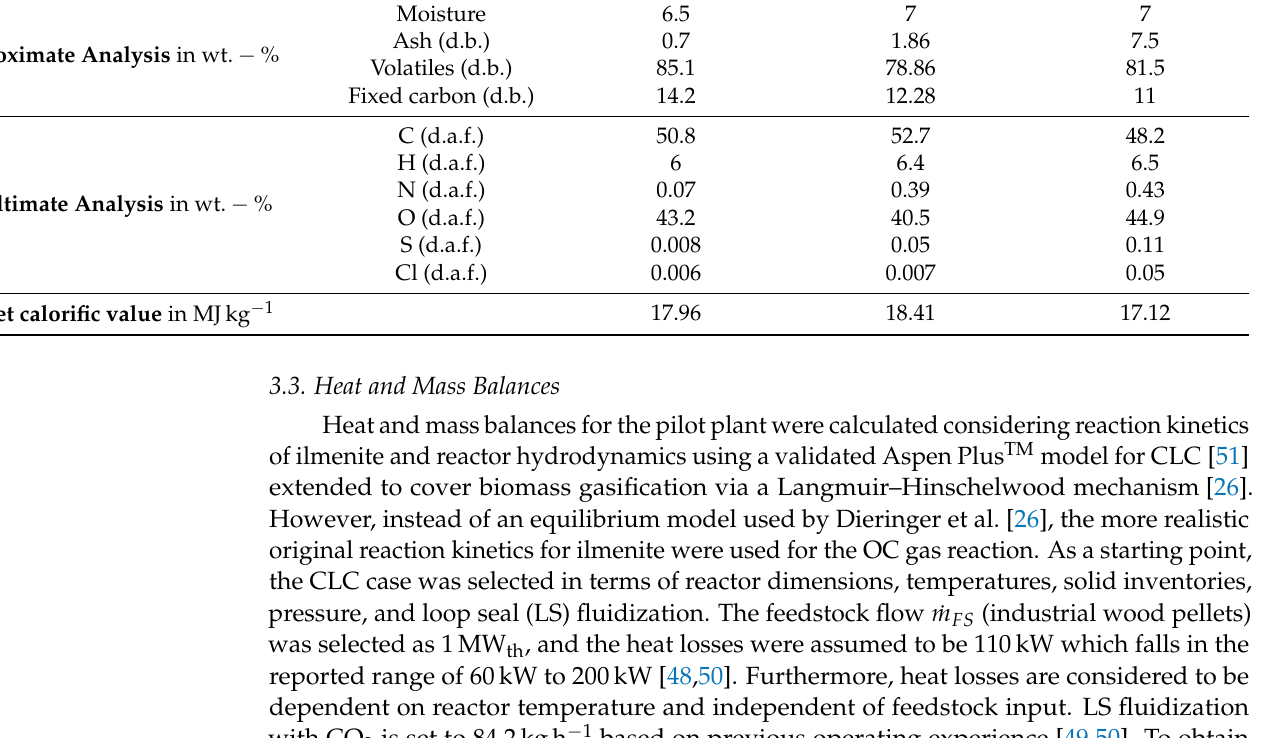
Proximate Analysis in wt. −